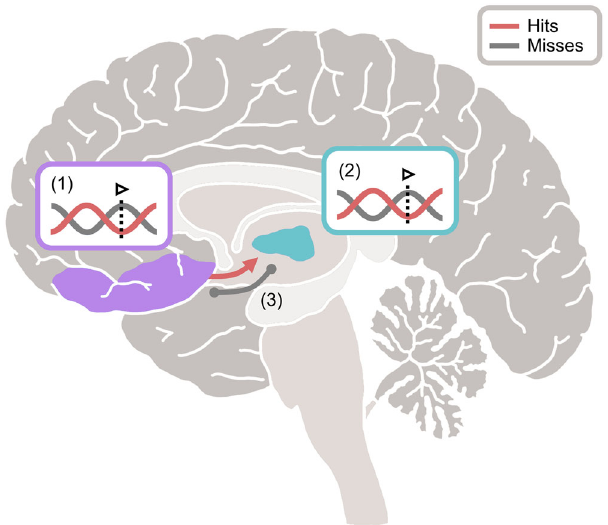
Fig. 4 Visual depiction of the main fi ndings. Successful detection of a visual stimulus correlates with several neural phenomena: (1) the stimulus being presented at the optimal, low-frequency phase of ongoing medial prefrontal activity (mPFC in purple; hits in red; misses in grey), (2) the stimulus being presented at the optimal, low-frequency phase of ongoing mediodorsal thalamic activity (mediodorsal thalamus in aqua; hits in red; misses in purple), and (3) directed prefrontal-to-thalamic low-frequency connectivity (hits in red; misses [which displayed undirected connectivity] in grey]). Critically, the contribution of the prefrontal cortex to visual detection appears to be mediated by the mediodorsal